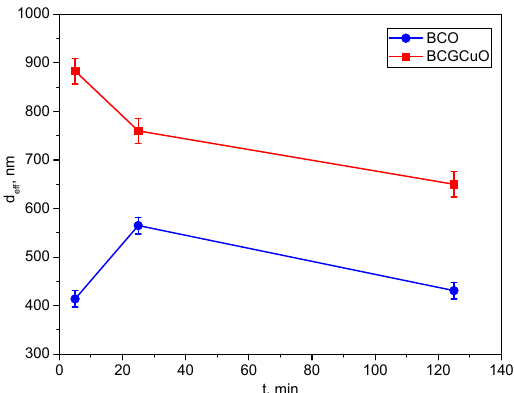
Figure 1. Dependence of the e ff ective hydrodynamic size of the aggregates (d e ff ) on the time of the ultrasonic treatment of the suspensions of BaCe 0.89 Gd 0.1 Cu 0.01 O 3 − δ (BCGCuO) and BaCeO 3 (BCO) powders.